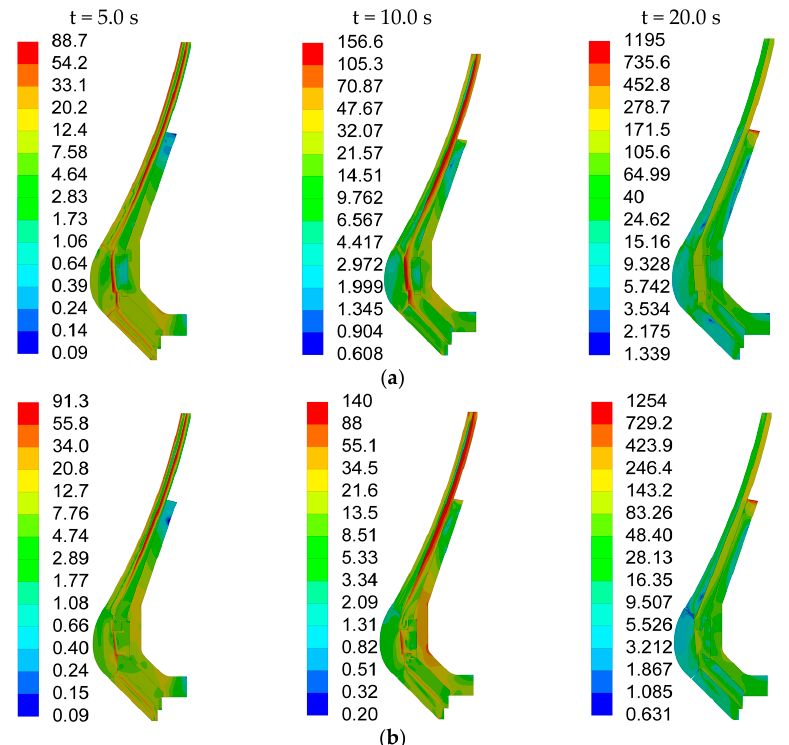
Figure 10. Von Mises stress distribution graphs for the two types of interface treating methods. ( a ) Bonded interfaces; ( b ) frictional interfaces. Energies 2016 , 9 , 430